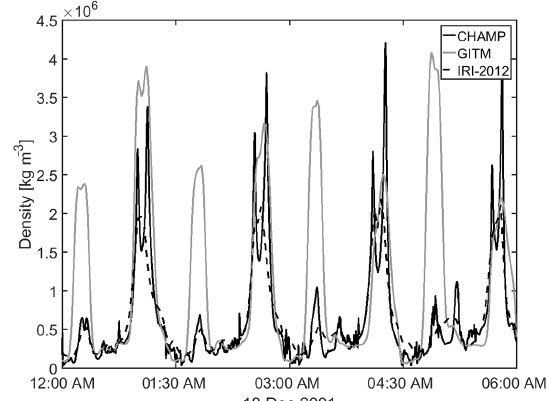
Figure 9. Comparison of electron number density as a function of time from GITM simulations (solid black line), CHAMP flight data (solid grey line) and a semi-empirical model (dashed